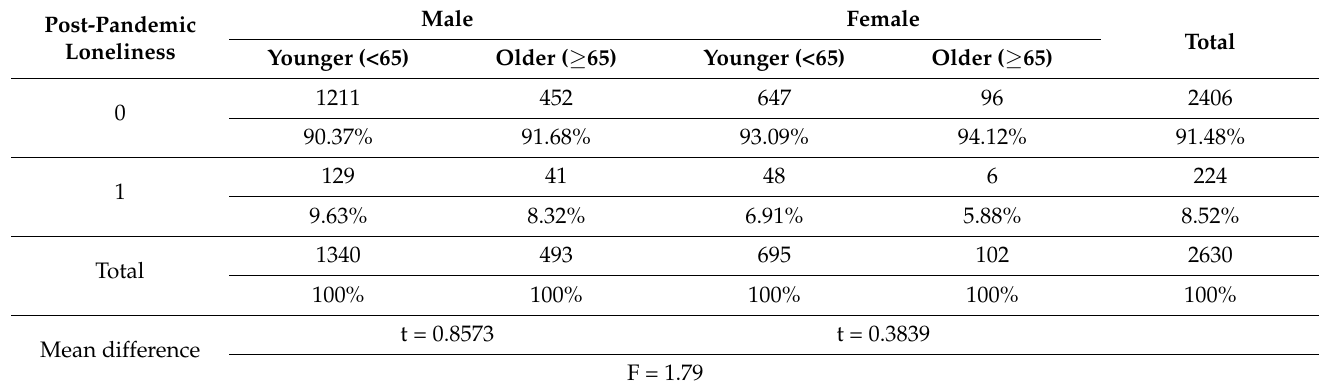
Table 4. Distribution of post-pandemic loneliness by gender and age